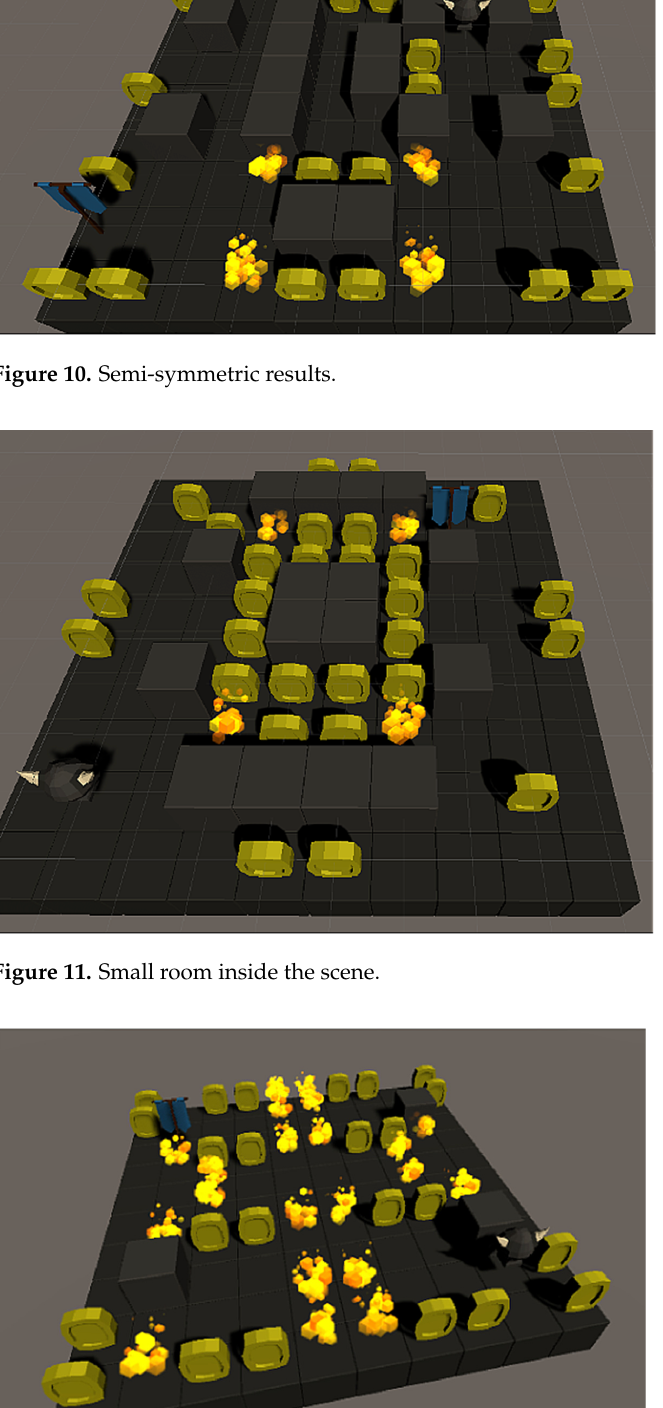
Figure 12. Game scene with almost no walls.